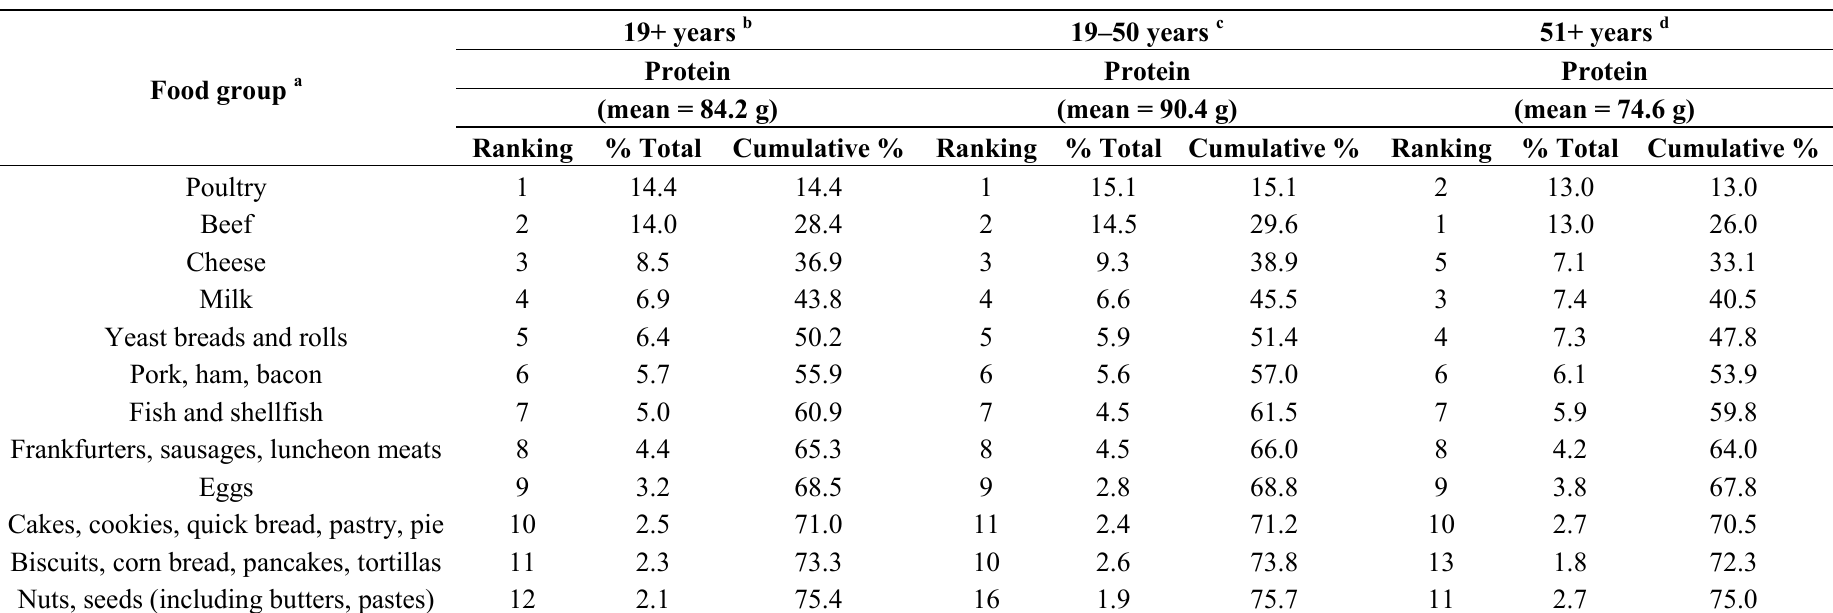
Table 3. Food sources of protein among US adults (from NHANES